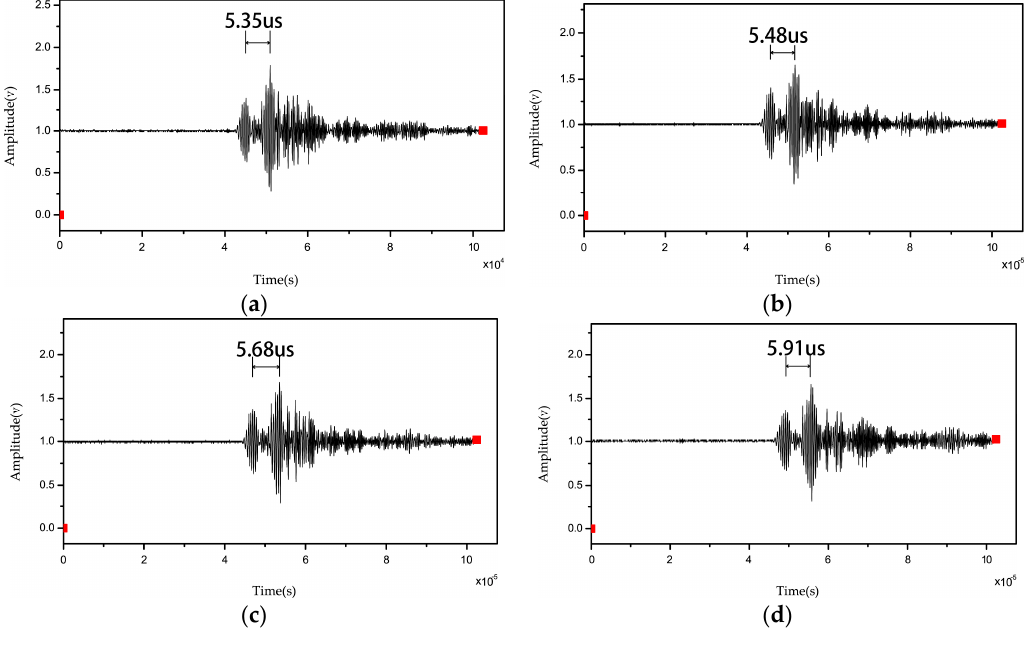
Figure 7. Delay time at ( a ) 26 ◦ C; ( b ) 500 ◦ C; ( c ) 1000 ◦ C; ( d ) 1500 ◦ C.